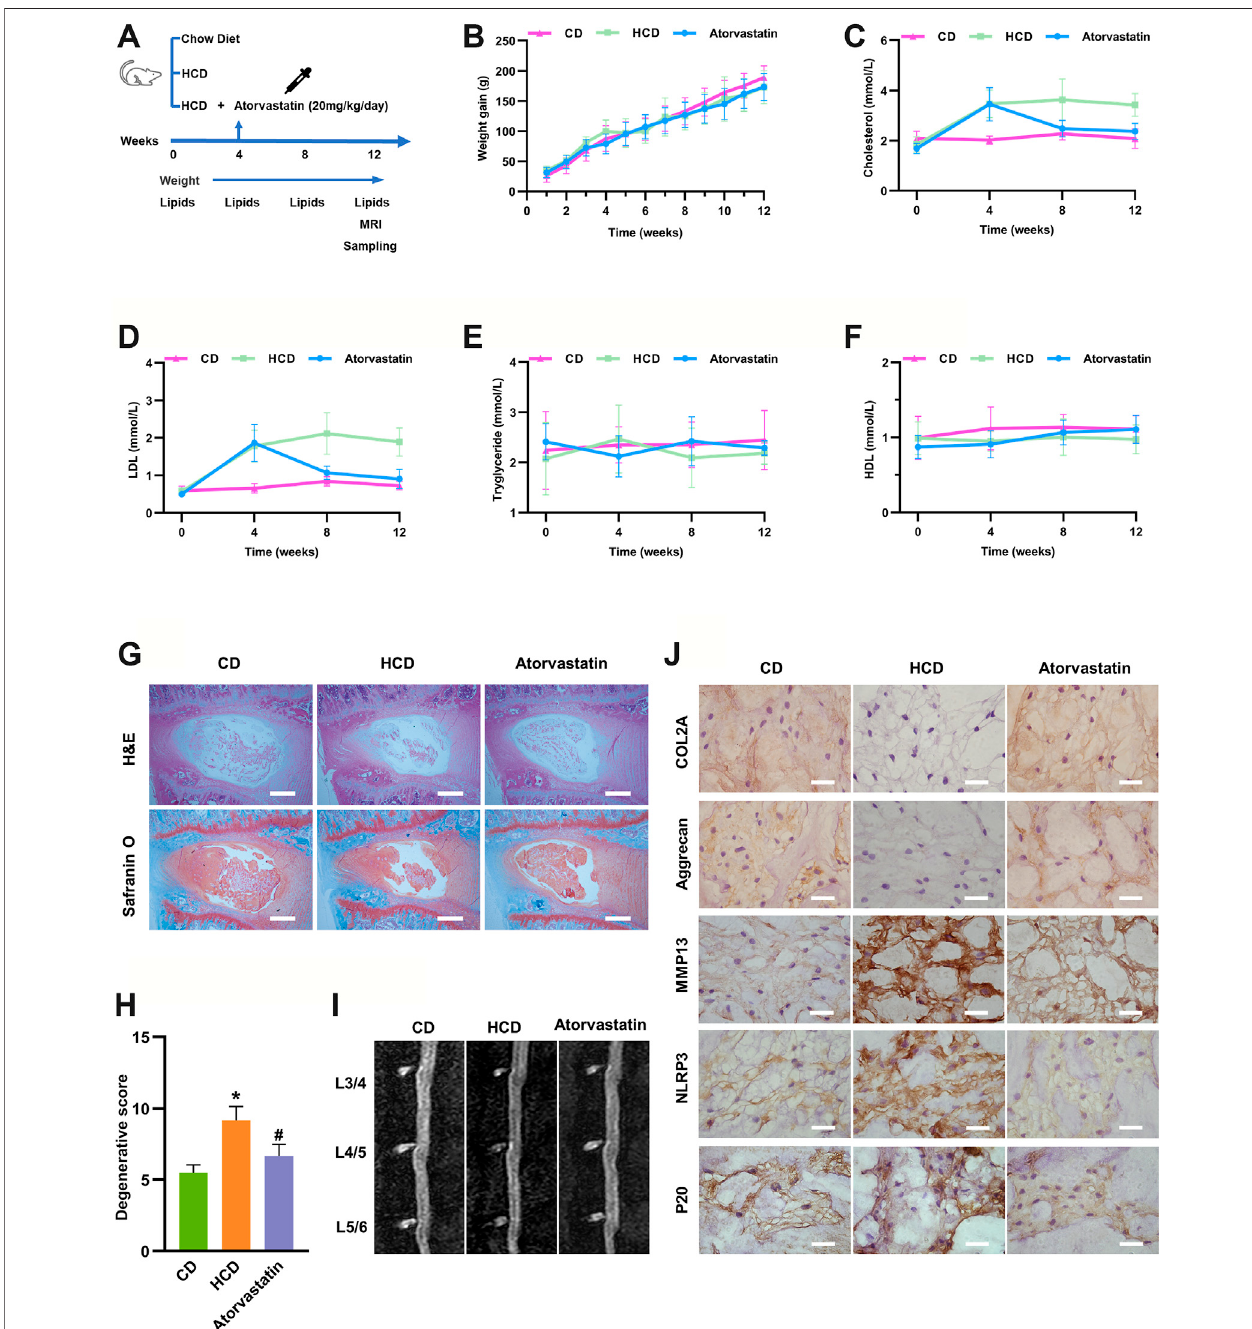
FIGURE 4 | Hypercholesterolemia induces IDD and pyroptosis-associated molecular changes, which were attenuated by atorvastatin. (A) Work fl ow diagram of animal experiments (B) Weight gain was not signi fi cantly different among SD rats fed different diets at any week (n (cid:1) 12). (C, D) Total serum cholesterol and LDL concentrations of SD rats fed different diets at different weeks (n (cid:1) 12). (E, F) Serum HDL (E) and triglyceride concentrations (F) of SD rats fed different diets at different weeks(n (cid:1) 12). (G , H) H&E and SafraninO/Fast green staining ofthelumbarintervertebral discsofSDrats showing that cholesterol inducedIDD in the HCDgroup after 3 months of speci fi c diets and that atorvastatin reversed this effect (bar (cid:1) 500 μ m). * p < 0.05 compared with CD group; # p < 0.05 compared with HCD group. (I) Representative sagittal lumbar MRI scans of SD rats fed different diets (J) The protein expression levels of the ECM components COL2A and aggrecan, catabolic metabolism marker MMP13, and pyroptosis-associated biomarkers NLRP3 and p20 were measured by IHC (bar (cid:1) 20 μ m). The data are presented as the mean ± SD. CD, chow diet.